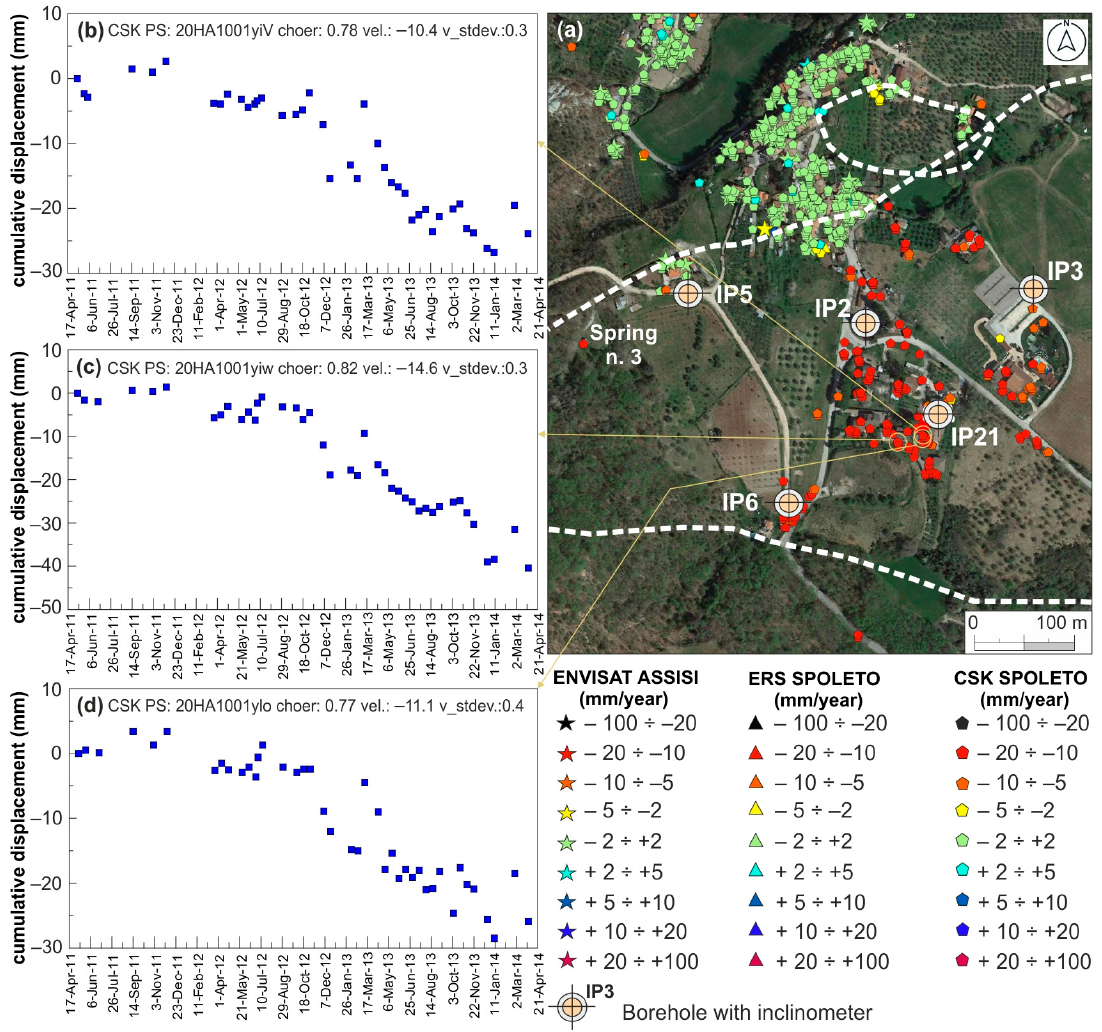
Figure 6. Cumulative displacement extracted from three PS points (only CSK ascending dataset have been selected). Data are in Table S1. (a ) Location of PS; ( b ) cumulative displacement of CSK PS: 20HA1001yiV; ( c ) cumulative displacement of CSK PS: 20HA1001yiw; ( d ) cumulative displacement of CSK PS 20HA1001ylo. Data are in Table S1.